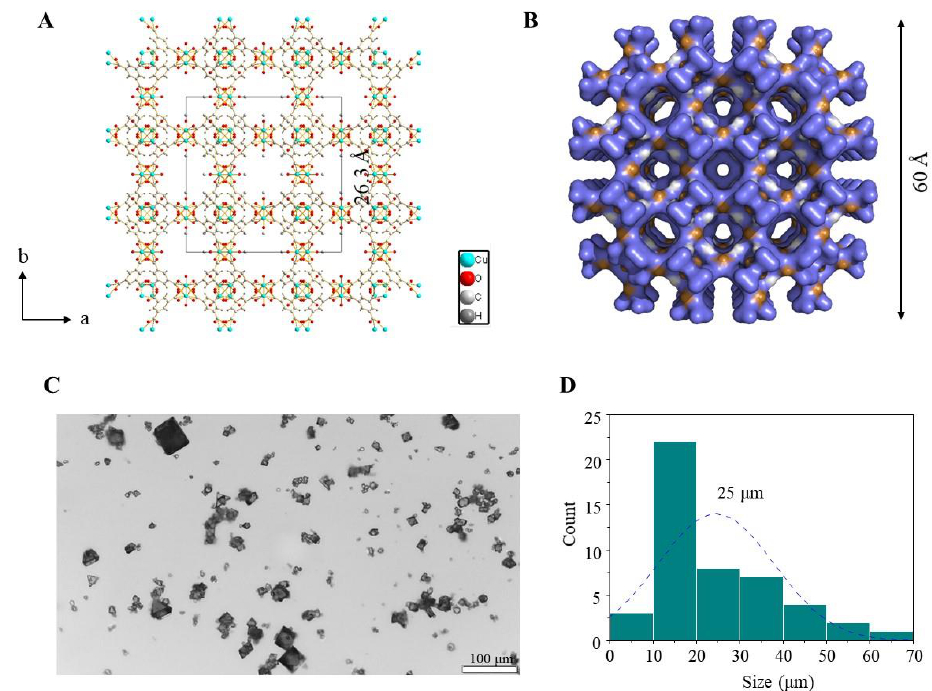
Figure 1. Micro-sized porous HKUST-1. ( A ) The crystal structure of the HKUST-1, ball-and-stick model (cubic, a = 26.3 Å). The formula of HKUST-1 is Cu 3 (C 9 H 3 O 6 ) 2 (H 2 O) 3 · χ H 2 O, abbreviated Cu 3 (BTC) 2 , BTC = 1,3,5-benzene tricarboxylate. ( B ) The porous surface of HKUST-1 was calculated by the software PyMol. ( C ) The optical microscope photographs of as-prepared HKUST-1. ( D ) Size distribution (histogram and Gaussian fit) determined from ( C ) with ImageJ software. The average grain size was determined using the equivalent circle diameter method.